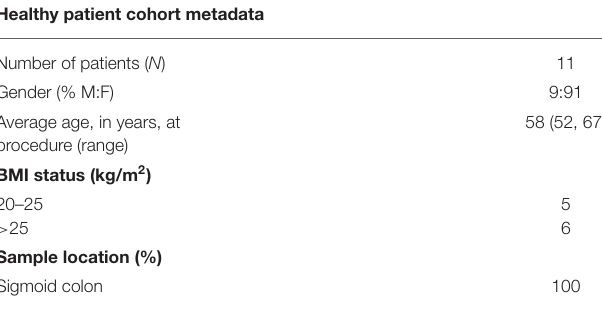
TABLE 1B | Study cohort information for healthy